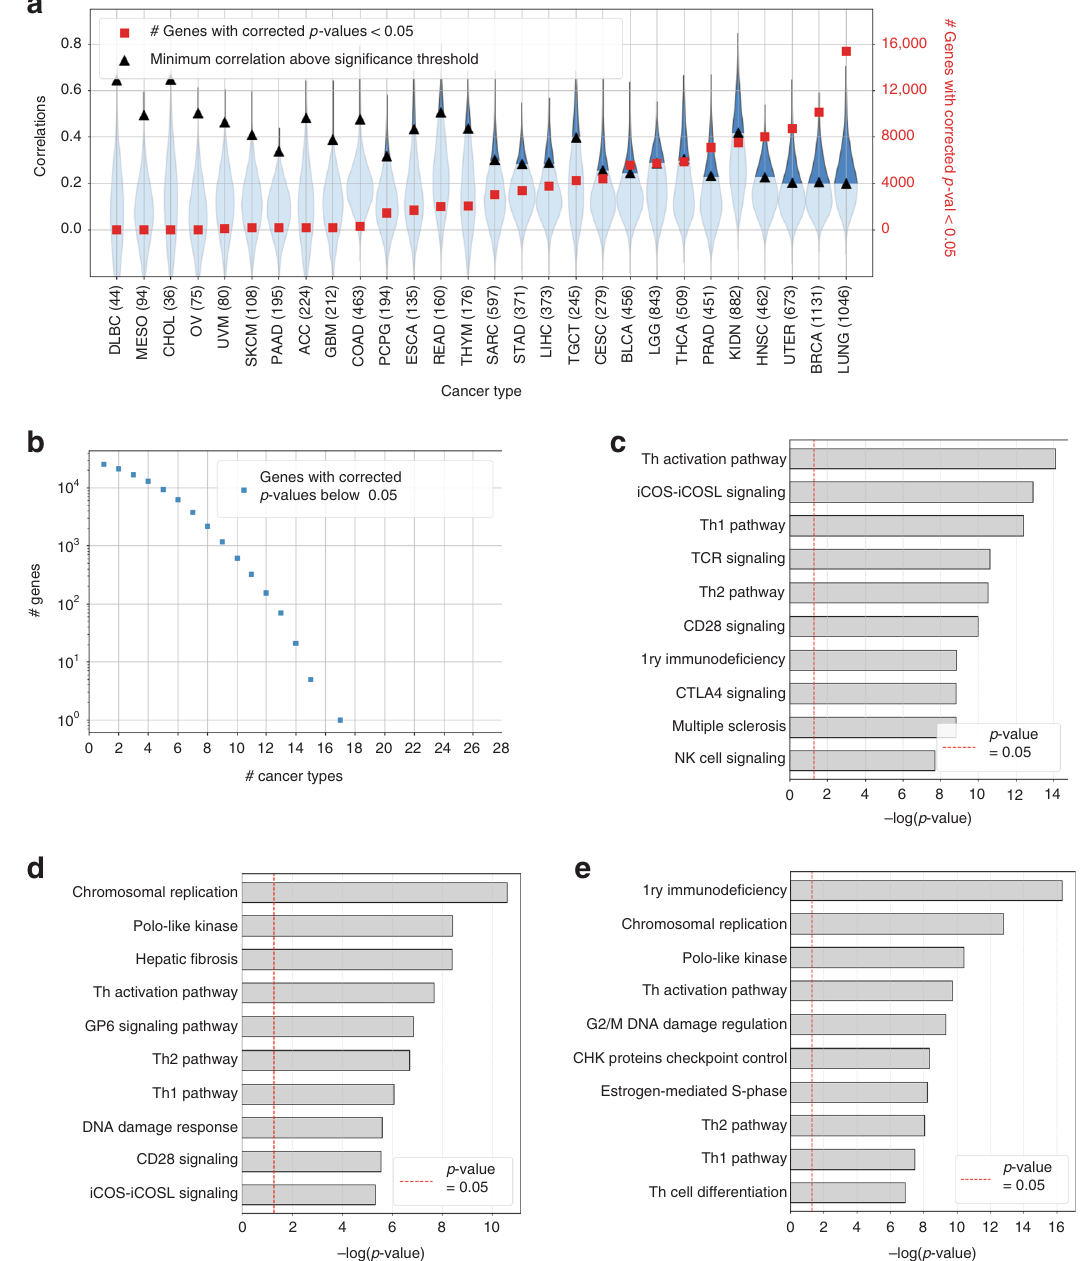
Fig. 2 Gene expression prediction results. a Distribution of Pearson correlation coef fi cients R averaged over the fi ve folds of cross-validation (left axis, blue violin plots) and number of coding and noncoding genes (right axis, red squares) with Holm – Š idák corrected p -values < 0.05 (one-sided empirical p -value, as described in “ Methods ” ), for 28 cancer types from the TCGA. Black triangles indicate the minimum correlation coef fi cient required for signi fi cance in any given dataset. b The number of coding and noncoding genes signi fi cantly well-predicted for a given number of cancer types, with Holm – Š idák corrected p -values < 0.05, as a function of the number of cancers. c Computational pathway analysis with ingenuity pathway analysis (IPA) software of the 156 best-predicted Pan TCGA genes, showing an enrichment in genes associated with immunity and tumor immune in fi ltration/activity. TCR: T-cell receptor, NK: natural killer. d IPA-based analysis of the more accurately predicted protein-coding genes in the LIHC dataset, showing an enrichment in genes associated with cell cycle and DNA damage response. LIHC: liver hepatocellular carcinoma. e IPA-based analysis of the more accurately predicted protein-coding genes in the BRCA dataset, showing an enrichment in genes associated with cell cycle and DNA damage response. Th cell differentiation: Th1 and Th2 cell differentiation. Th activation pathway: Th1 and Th2 activation pathway, 1ry: Primary. In c – e red dashed line = − log( p -values = 0.05), BRCA: breast cancer, p -values were calculated using right-tailed Fisher ’ s exact in cell-cycle regulation were among the most accurately pancreatic adenocarcinoma (PAAD), 29% of the angiogenesis predicted for the BRCA dataset. network, and 23% of the hypoxia pathway genes in pheochro- As a control experiment, we used HE2RNA to predict the level mocytoma and paraganglioma (PCPG). These results con- fi rmed our previous analysis (Fig. 2e) in which genes involved of expression of housekeeping genes (HK) (Supplementary